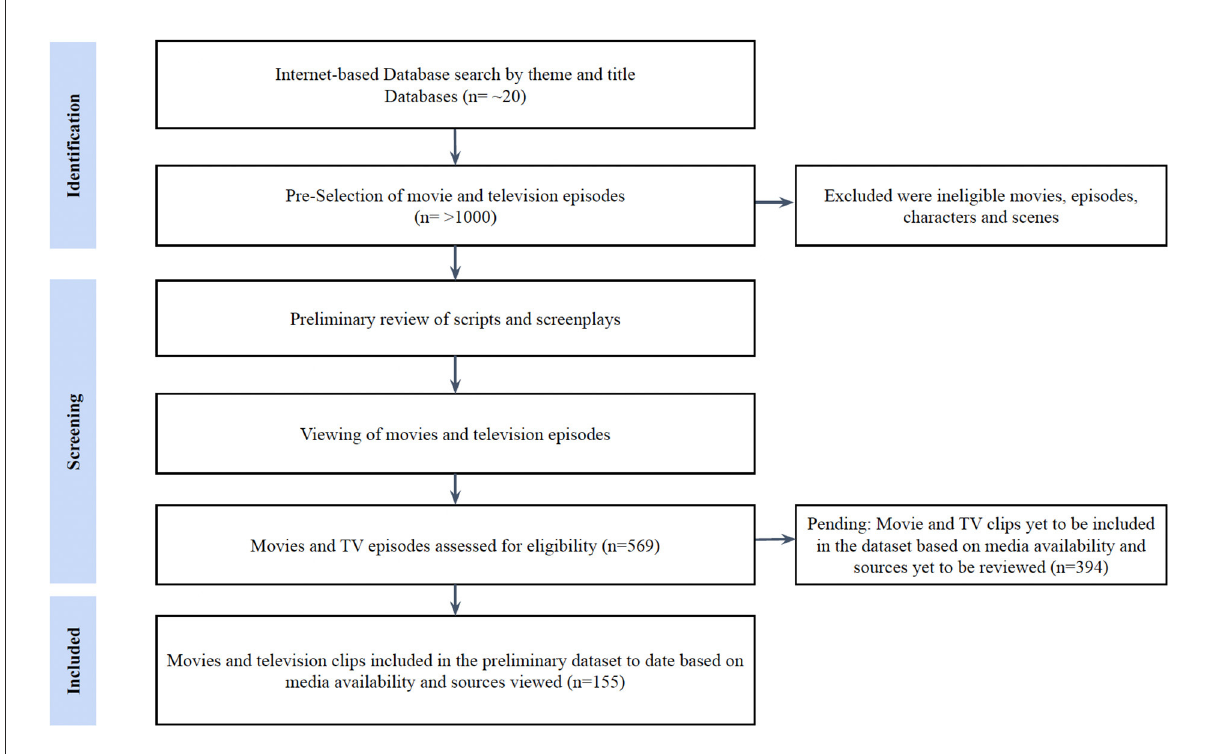
FIGURE1 Diagram of workflow steps (data collection and primary curation) for creating the SBSI